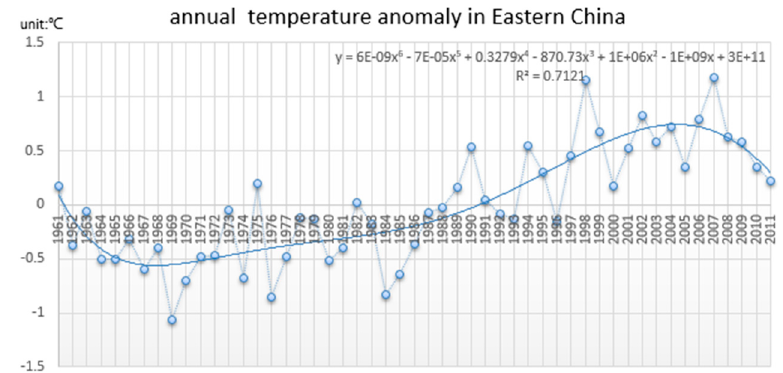
Figure 4. The inter-annual variability of average temperature anomaly in eastern China from 961 to 2011.